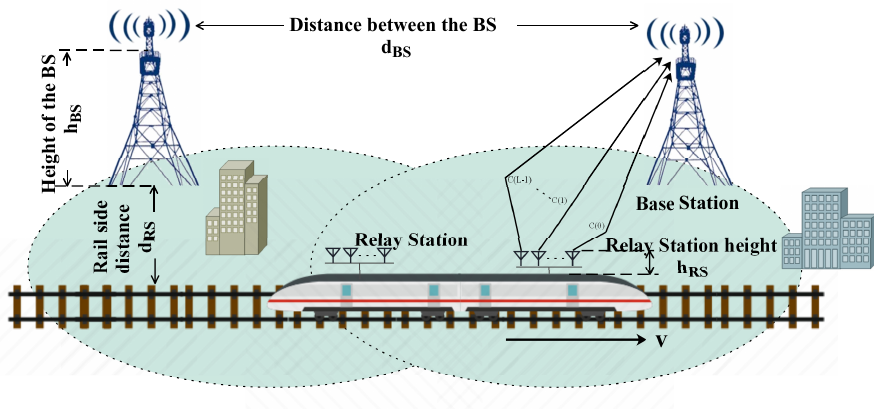
Figure 1. Massive MIMO system model on high-speed